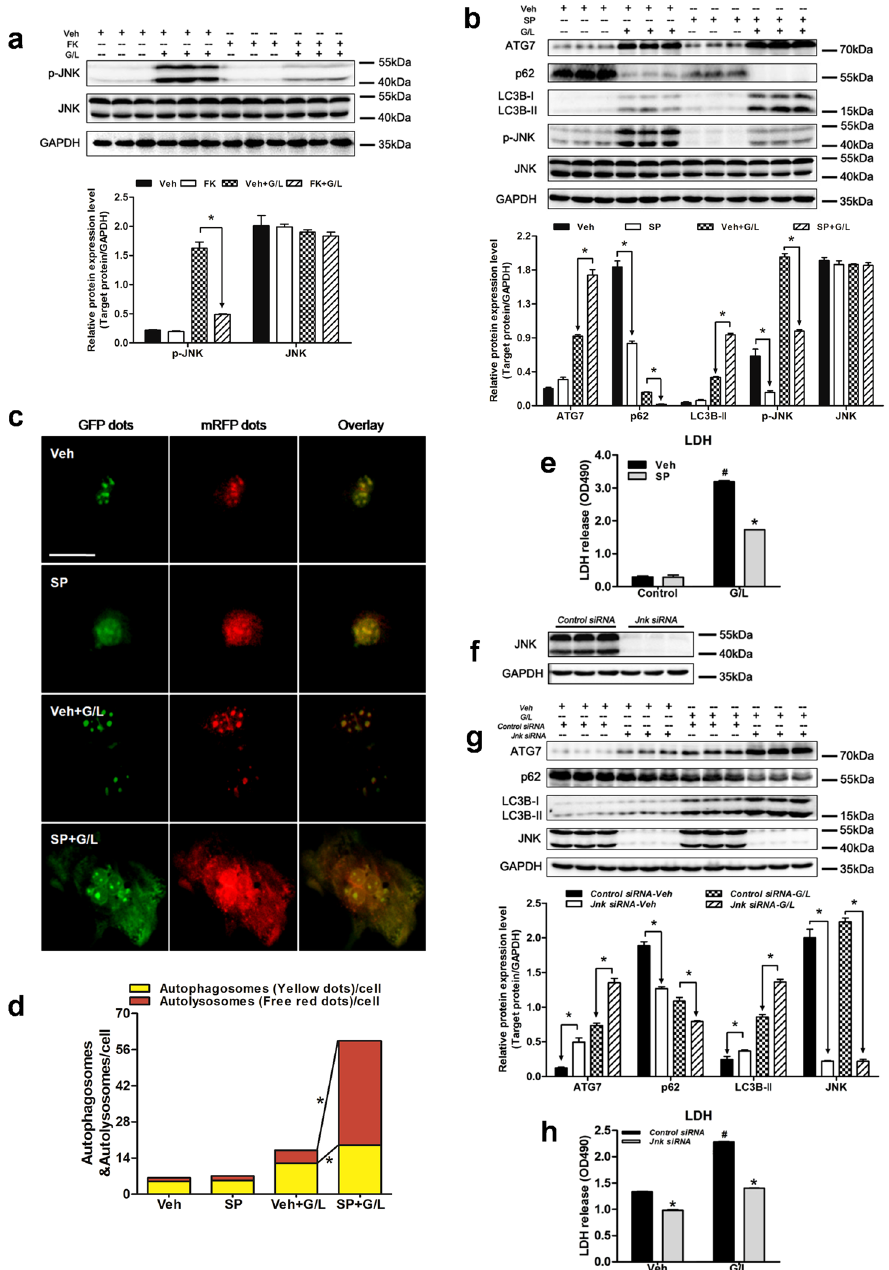
Figure 7. FK866-induced autophagy is associated with JNK signaling in primary hepatocytes. Hepatocytes were treated with SP600125 (SP, 20 µ mol/L, 30 min) or transfected with Jnk siRNA (100 nmol/L, 48 h) prior to GaIN/LPS (G/L, 1 mg/mL /30 ng/mL, 24 h) challenge. ( a ) JNK activity was examined by western blot. The data are shown as the means ± SEM of three independent experiments performed in duplicate. * P < 0.05 indicates significant differences. ( b ) The protein expression levels of p-JNK, JNK, and autophagy indicators are shown as densitometric graphs of the optical density-based data of immunoblot. The data are shown as the means ± SEM of three independent experiments. * P < 0.05. ( c ) Representative fluorescence micrographs showed autophagy vacuoles in hepatocytes with G/L in the presence of SP or vehicle (Veh) from a pool of at least 10 images. Original magnification × 200, scale bar 50 µ m. ( d ) Quantification of autophagosomes and autolysosomes. * P < 0.05. ( e ) Measurement of LDH release of primary hepatocytes. The data are shown as the means ± SEM of three independent experiments. * P < 0.05 vs. the corresponding Veh group. # P < 0.05 vs. the corresponding control group. ( f ) JNK protein expression was effectively suppressed using Jnk -specific siRNA in hepatocytes. ( g ) Western blot analysis of JNK, ATG7, p62, and LC3B expression in the presence or absence of Jnk siRNA. The data are shown as the means ± SEM of three independent experiments. * P < 0.05. ( h ) Determination of LDH levels in the cultured medium. The data are shown as the means ± SEM of three independent experiments. * P < 0.05 vs. the corresponding Control siRNA group. # P < 0.05 vs. the corresponding Veh